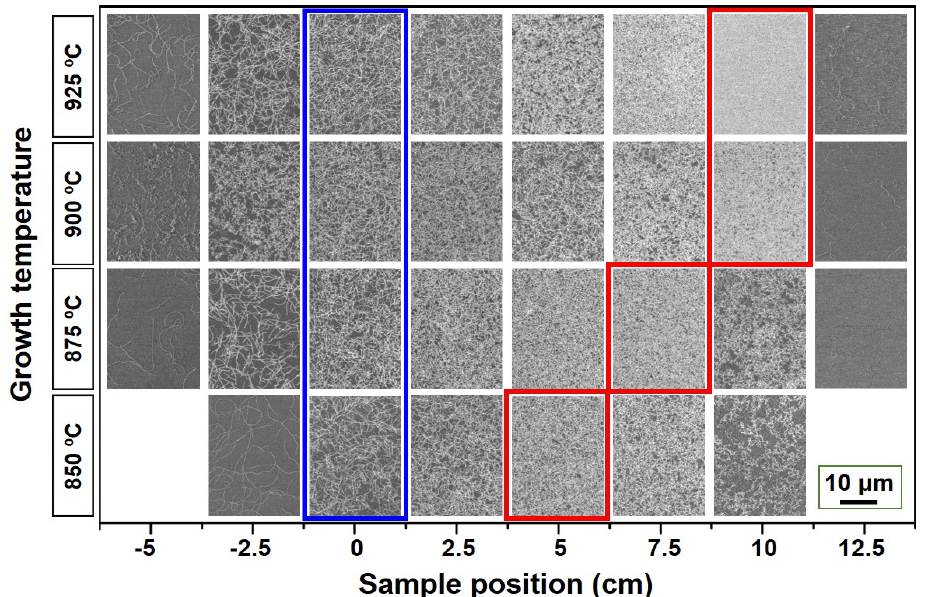
Figure 4. HRSEM images showing the growth results for SWNTs depending on the growth temperature and sample position. SEM images from the central region and maximum-synthesis-yield regions are highlighted with blue and red boxes, respectively.